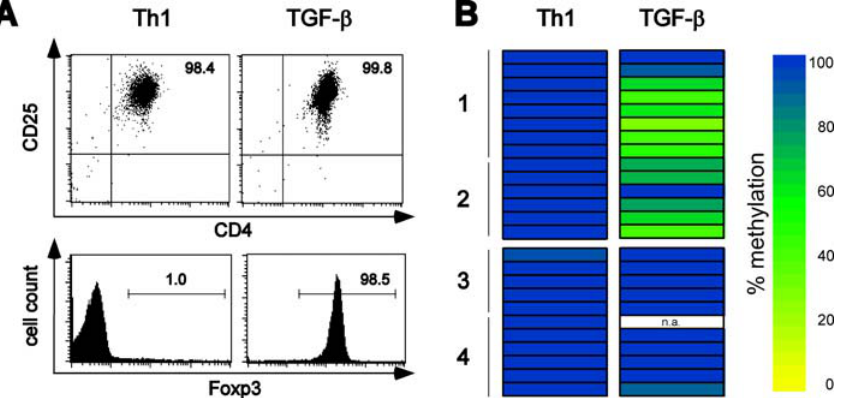
Figure 6. TGF- b –Induced Tregs Harbor Partially Demethylated CpG Motifs within the foxp3 Locus (A) CD25 (cid:1) CD4 þ T cells sorted from spleens and LNs pooled from 20 male BALB/c mice were cultured for 6 d in the presence of TGF- b . Cells cultured under Th1 conditions were used as control. Within the starting population, less than 1% of the cells were Foxp3 þ (unpublished data). On day 6, cultured cells were sorted by FACS for CD25 þ cells. FACS analysis shows the purity of sorted subsets (upper panel) and Foxp3 expression in gated CD25 þ cells derived from indicated cultures (lower panel). Numbers display frequency of cells within indicated populations. The bars in the lower graphs indicate the marker gate for Foxp3 þ cells. The vertical and horizontal lines in the upper graphs indicate the quadrant used to identify the CD4 þ CD25 þ / (cid:1) subsets. (B) Methylation pattern of selected amplicons of the foxp3 locus in sorted CD25 þ cells derived from indicated cultures. The methylation status of individual CpG motifs within the four amplicons is color coded as described in Figure 2. One representative experiment out of two individual experiments is shown. n.a., not analyzed.